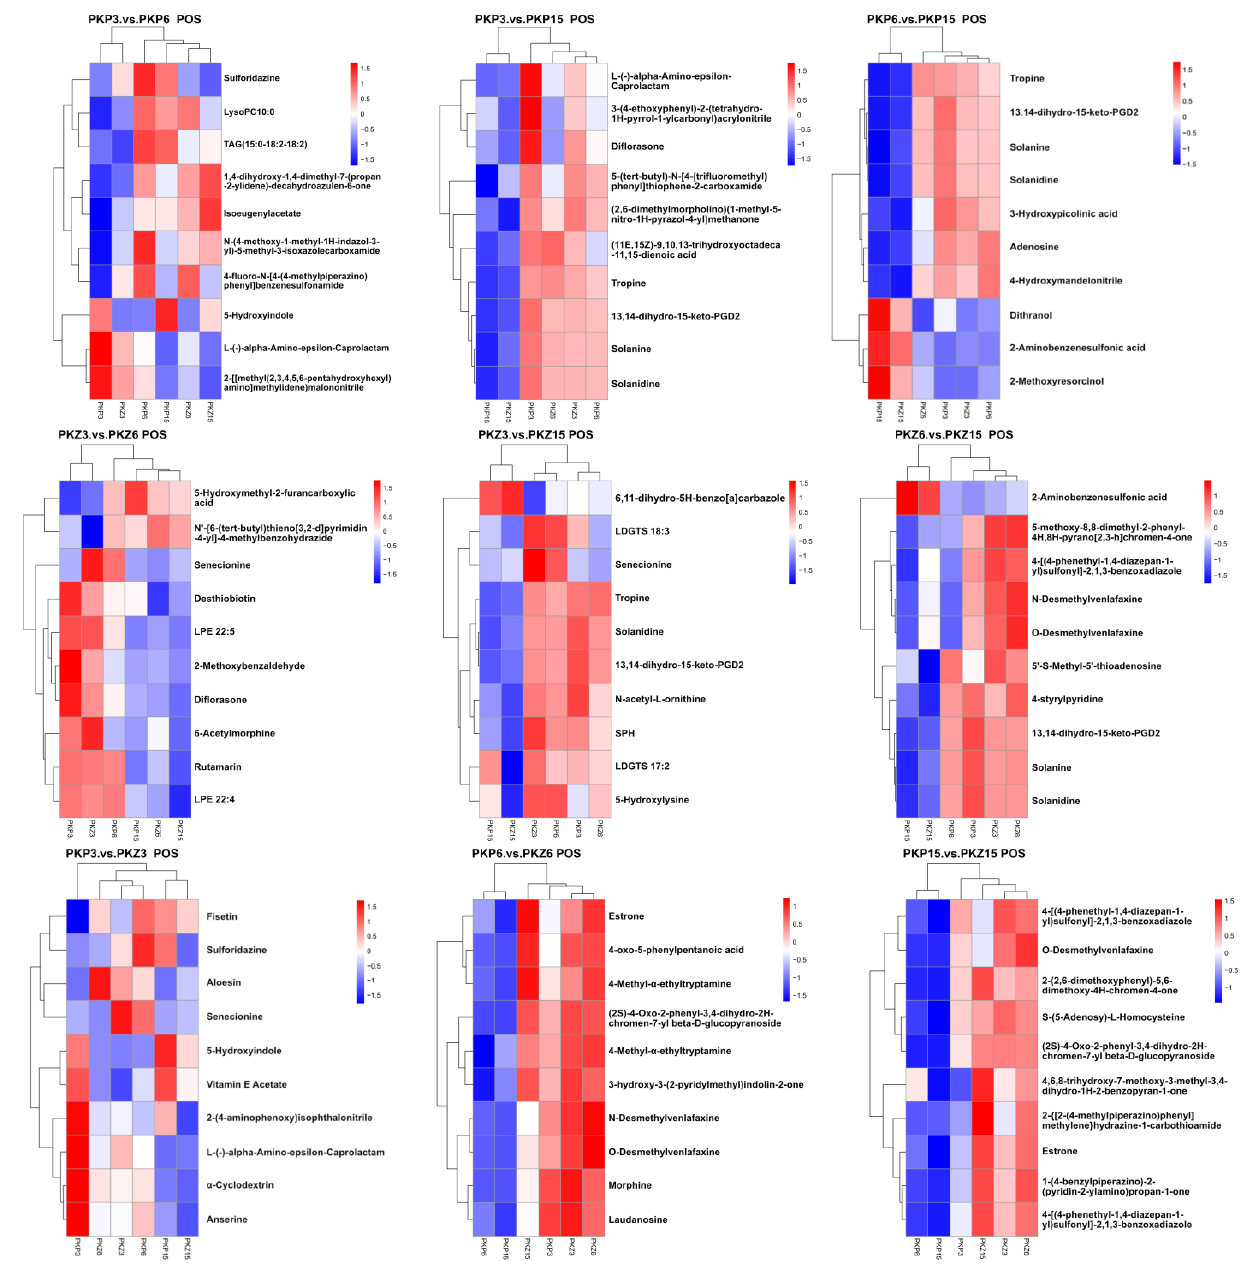
Figure 7. Hierarchical clustering results of significant differential metabolites (top 10 in each com- parison group, positive ion mode). The figure shows the results of the hierarchical clustering of metabolites within and between groups (red indicates the upregulation of metabolites, and blue indicates downregulation). The longitudinal axis is the clustering of samples, and the transverse axis is the clustering of metabolites. A shorter clustering branch indicates higher similarity. PKP3–PKZ15 is the same as in Table 1. POS: positive ion mode.